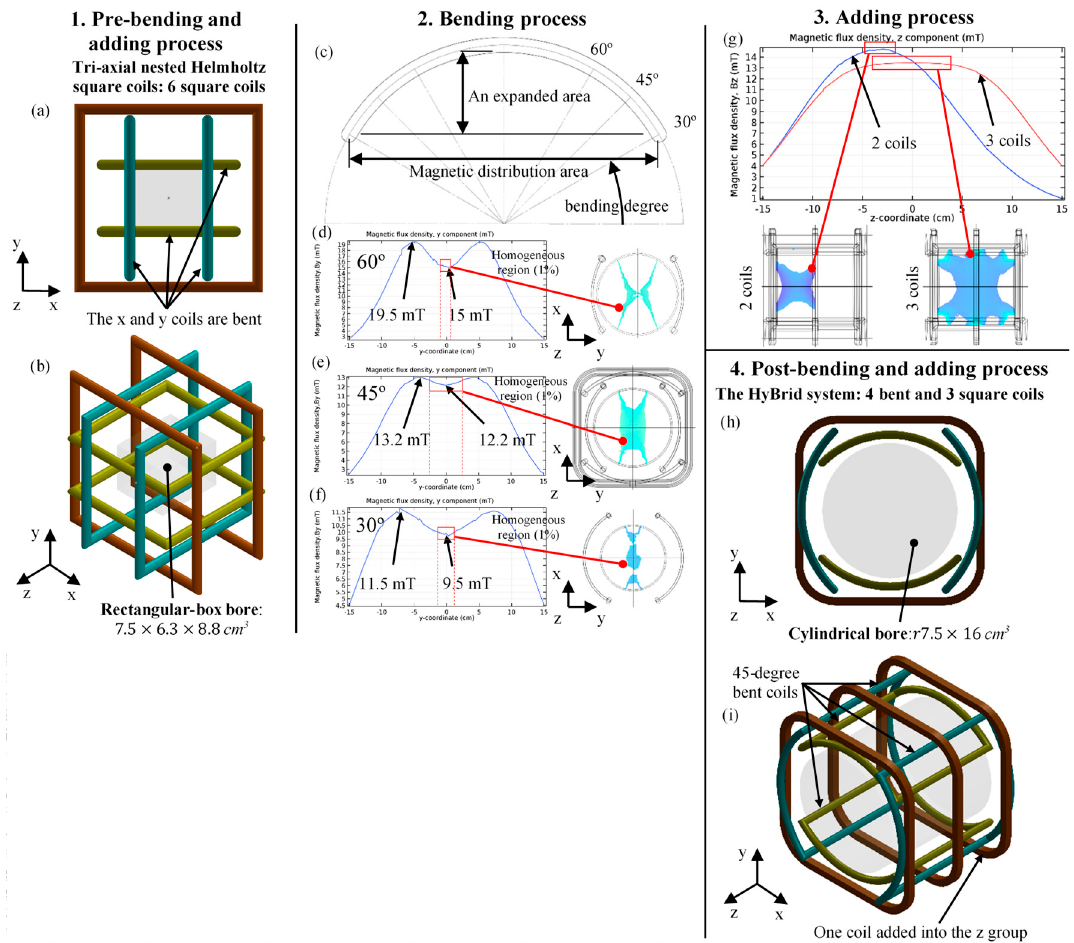
Figure 3. The optimization process from the prototype to the HyBrid system. l. Pre-bending and adding process; ( a , b ) Tri-axial nested Helmholtz square coil consists of three pairs of six square coils perpendicular to each other (the coil square size: 150, 175, 200 mm) with an available bore about 7.5 × 6.3 × 8.8 cms represented by the grey cube. 2. Bending process; ( c ) the x and y coil pair are bent to increase volume ofthe workspace. Three bending angles are considered, 60°, 45° and 30°. Each of the bending angles is simulated to investigate uniform field generation to the cylindrical workspace about r 7.5 × 16 cm 3 . Result of ( d ) 60° angle reports 15 mT with a homogeneous region about 8% of the workspace, ( e ) 45° angle reports 12.2 mT with a homogeneous region about 35% of the workspace, ( f ) 30° reports 9.5 mT on its homogeneous region about 15% of the workspace. After bending, space on the x – y -plane expands about 370%. 3. Adding process; one more coil is added into the z-coil group. Then, space along the z-direction is prolonged about 180%. Field magnitude about 13.5 mT has a homogeneous region about 70% ofthe workspace. Uniform magnetic field exhibited by the plots and the homogeneous region depicted by the blue area on the cross-sectional area of the cylindrical workspace. 4. Post-bending and adding process; ( h , i ) finally, the prototype, Tri-axial nested Helmholtz square coil becomes the HyBrid system. The original cubic workspace turns to be the cylindrical workspace with 680% larger.